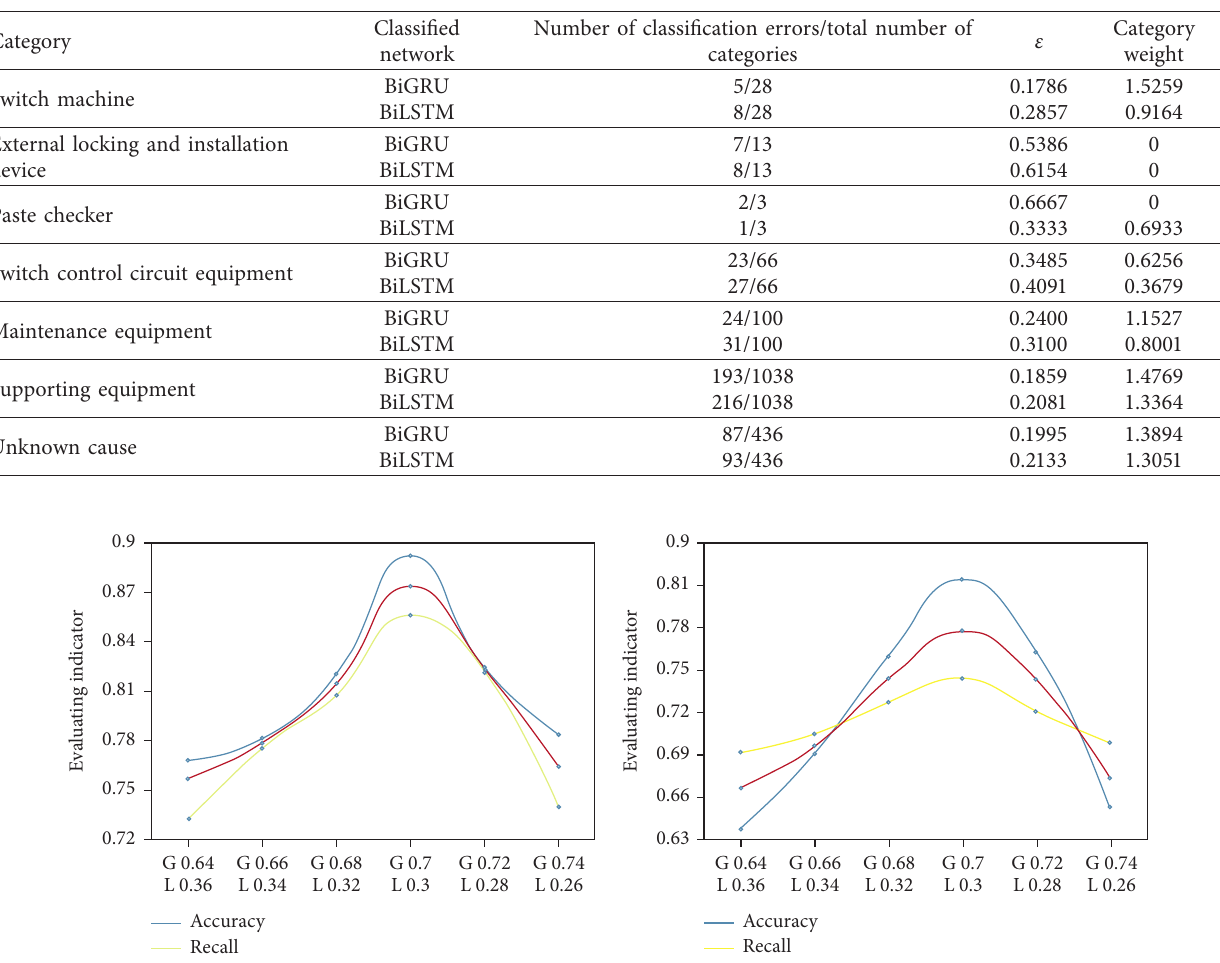
Table 3: Weight calculation results of the signal fault category of the first-level